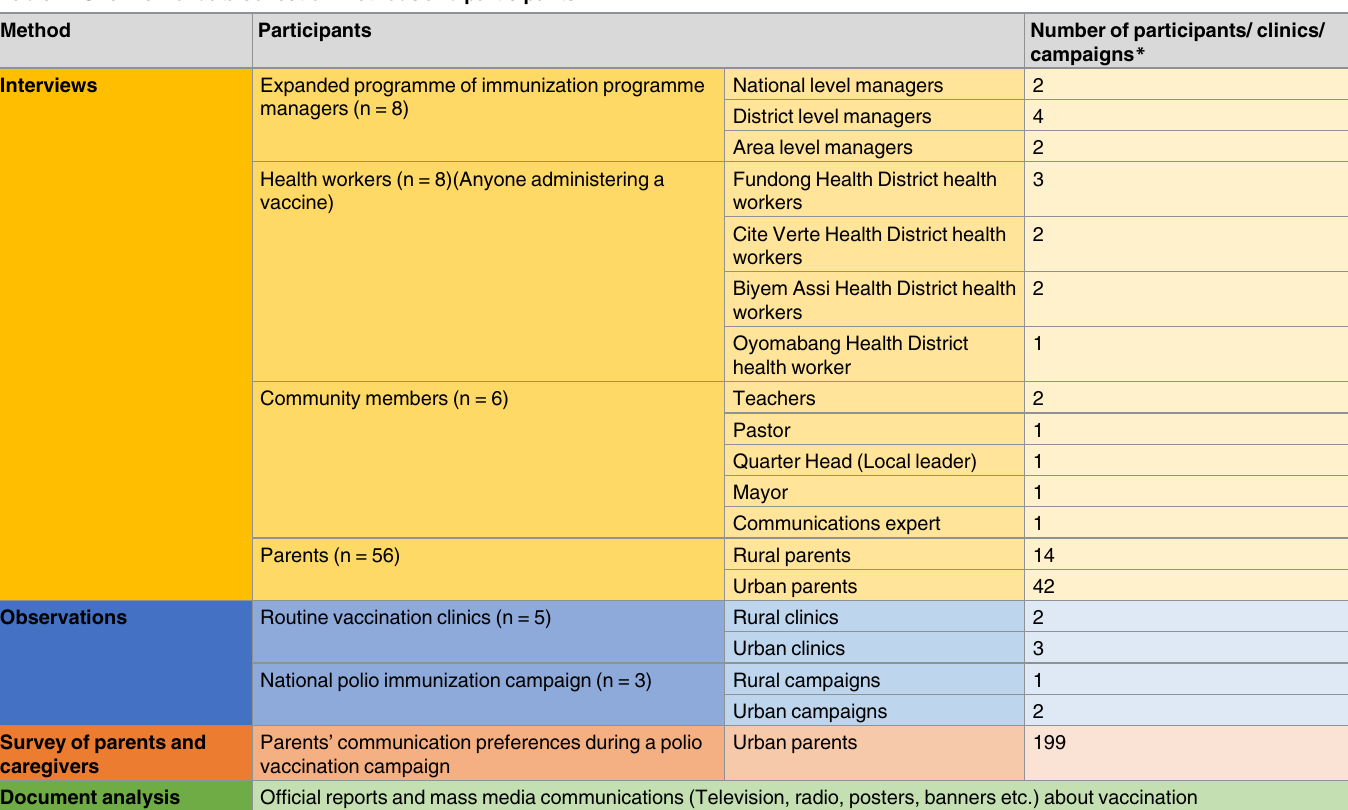
Table 1. Overview of data collection methods and